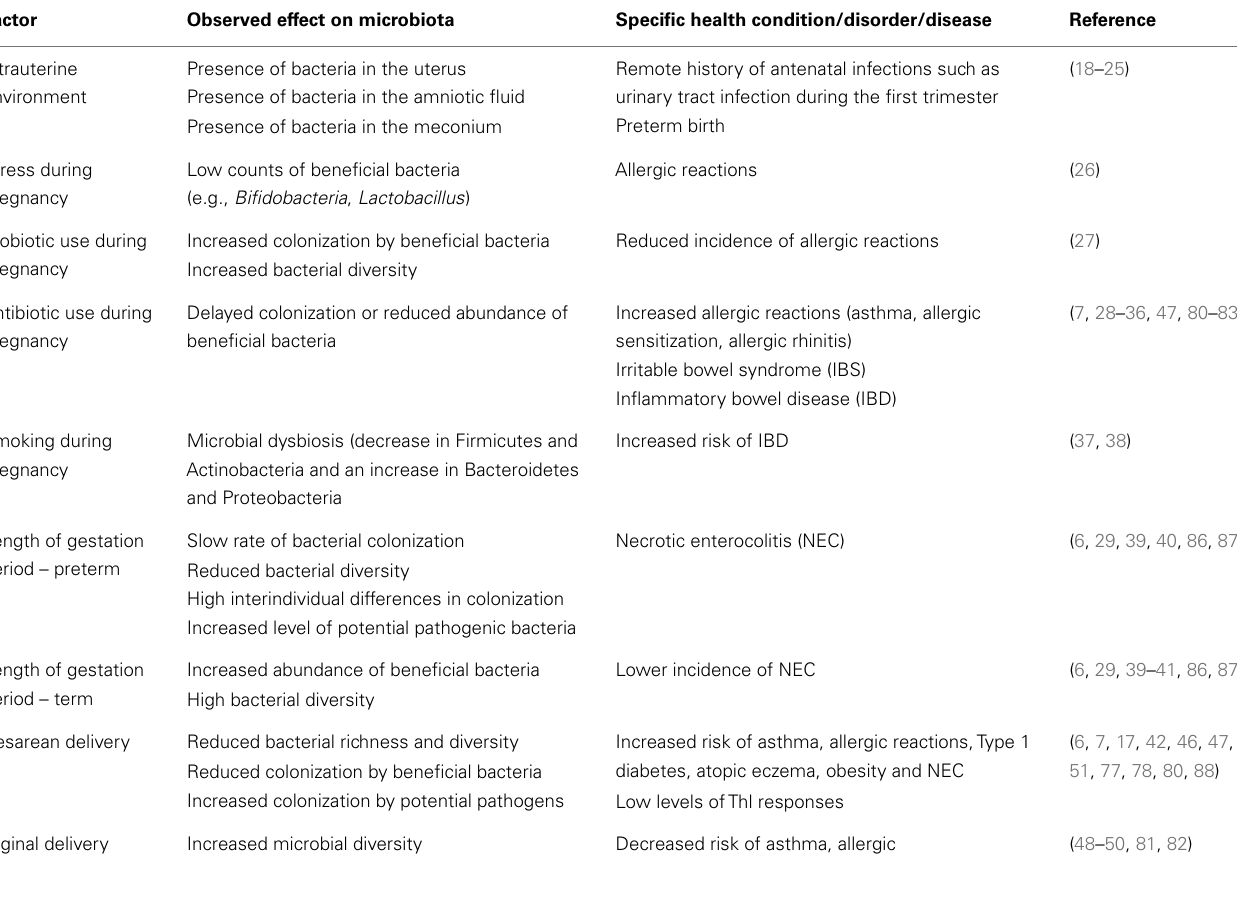
Table 2 | Factors affecting colonization of gut microbiota in neonates and infants or children, specific microbial effect, and the resultant health conditions